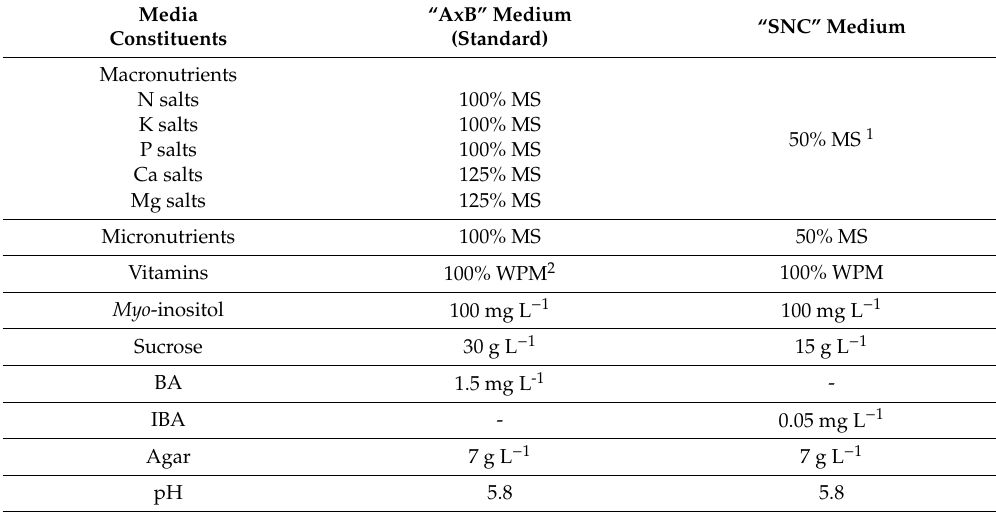
Table 1. Composition of media used for micropropagation of mountain